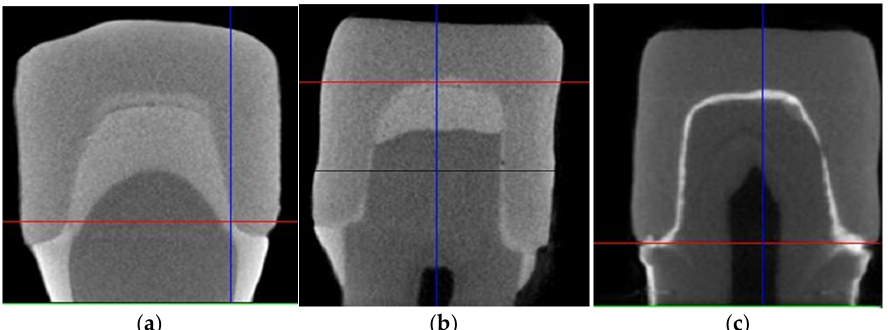
Figure 5. Micro-CT images of microleakage assessments among ( a ) Group 1-resin cement, ( b ) Group 2-ACTIVA, and ( c ) Group